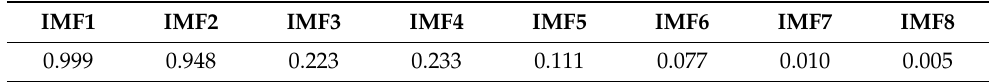
Figure 23. EEMD decomposition results of the rolling element fault signal and envelope spectrum of the two methods. ( a ) EEMD decomposition results of rolling element fault sign. ( b ) Envelope spectrum of the two methods. Table 6. Correlation coefficient of IMF components.